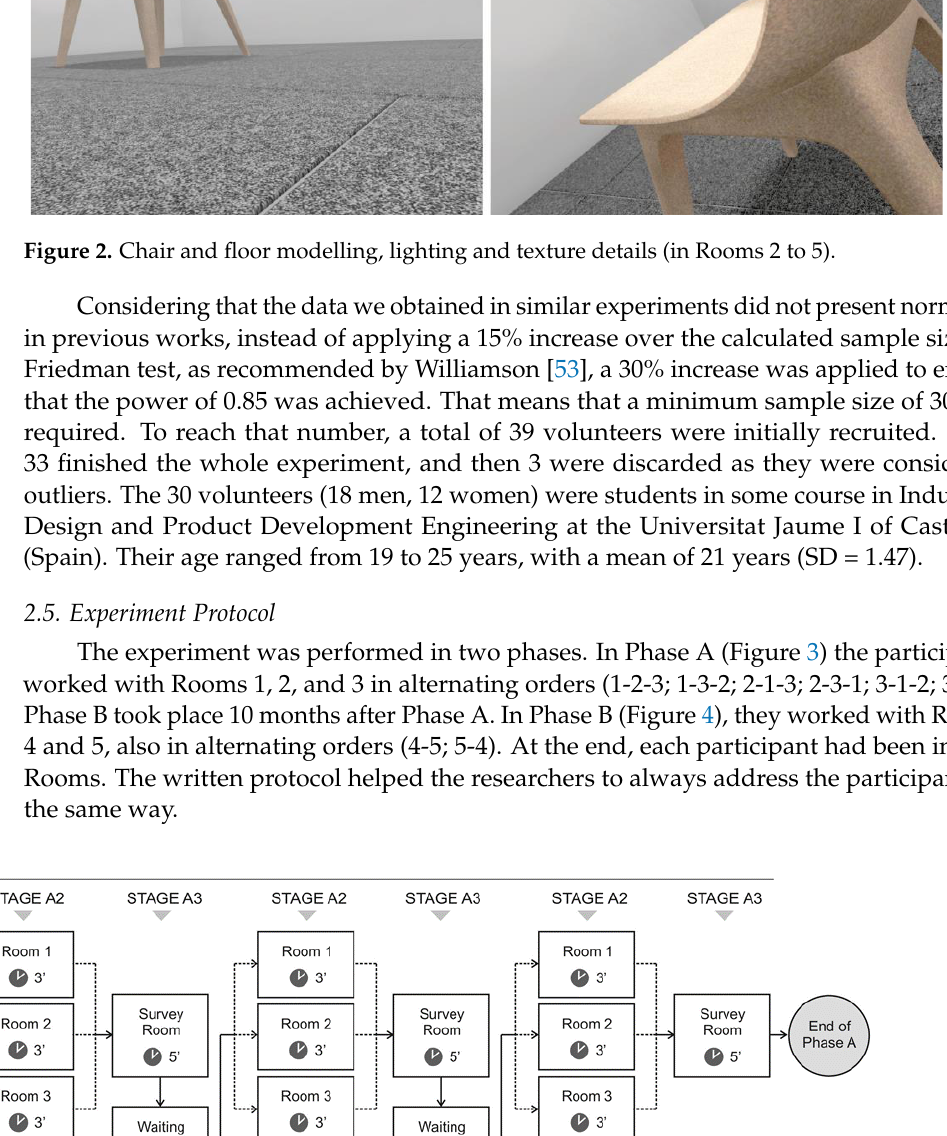
Figure 2. Chair and floor modelling, lighting and texture details (in Rooms 2 to 5).